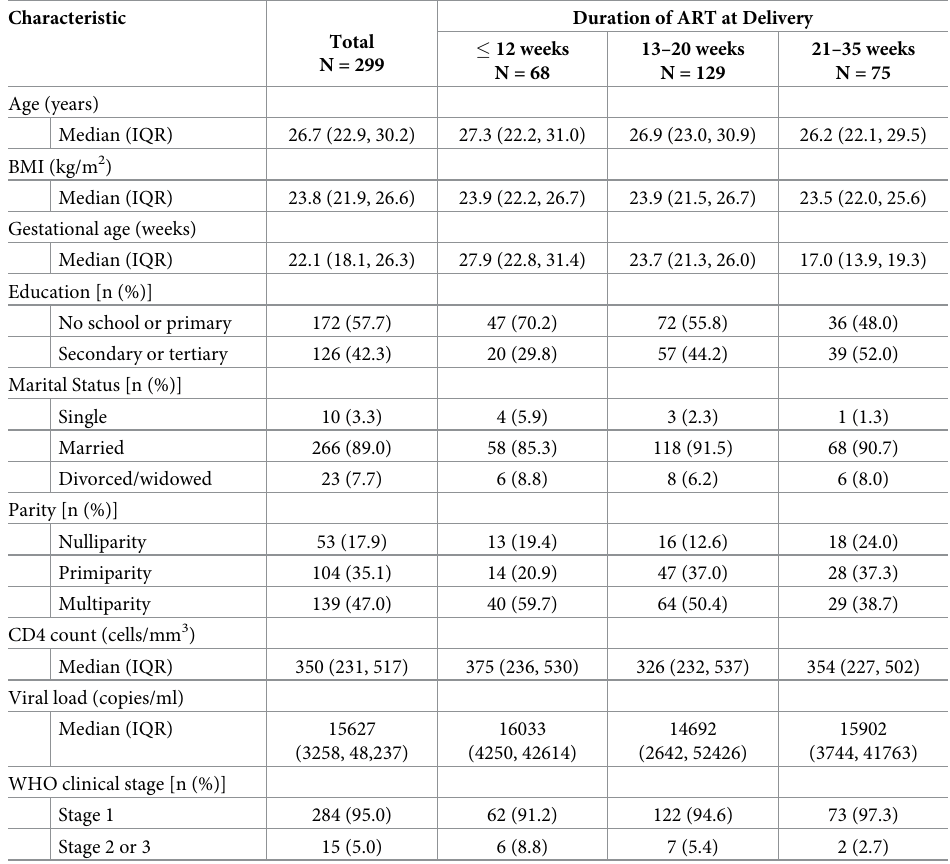
Table 1. Characteristics of the participants at enrollment.